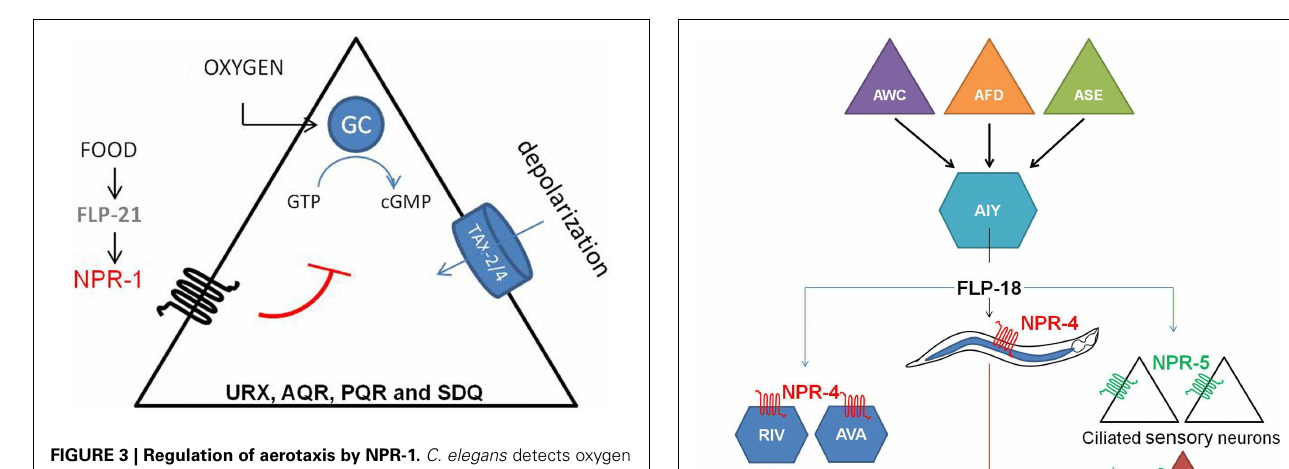
FIGURE 3 | Regulation of aerotaxis by NPR-1. C. elegans detects oxygen through the URX, PQR, AQR, SDQ neurons. Oxygen sensing in these neurons is mediated by soluble guanylate cyclase homologs (sGC-35 and sGC-36).When ambient oxygen levels decrease, cGMP levels rise and the cGMP gatedTAX-2/TAX-4 ion channel opens, which leads to the depolarization of the neurons. Activation of NPR-1 in the presence of food inhibits this activation (Cheung et al., 2005; Chang et al., 2006).